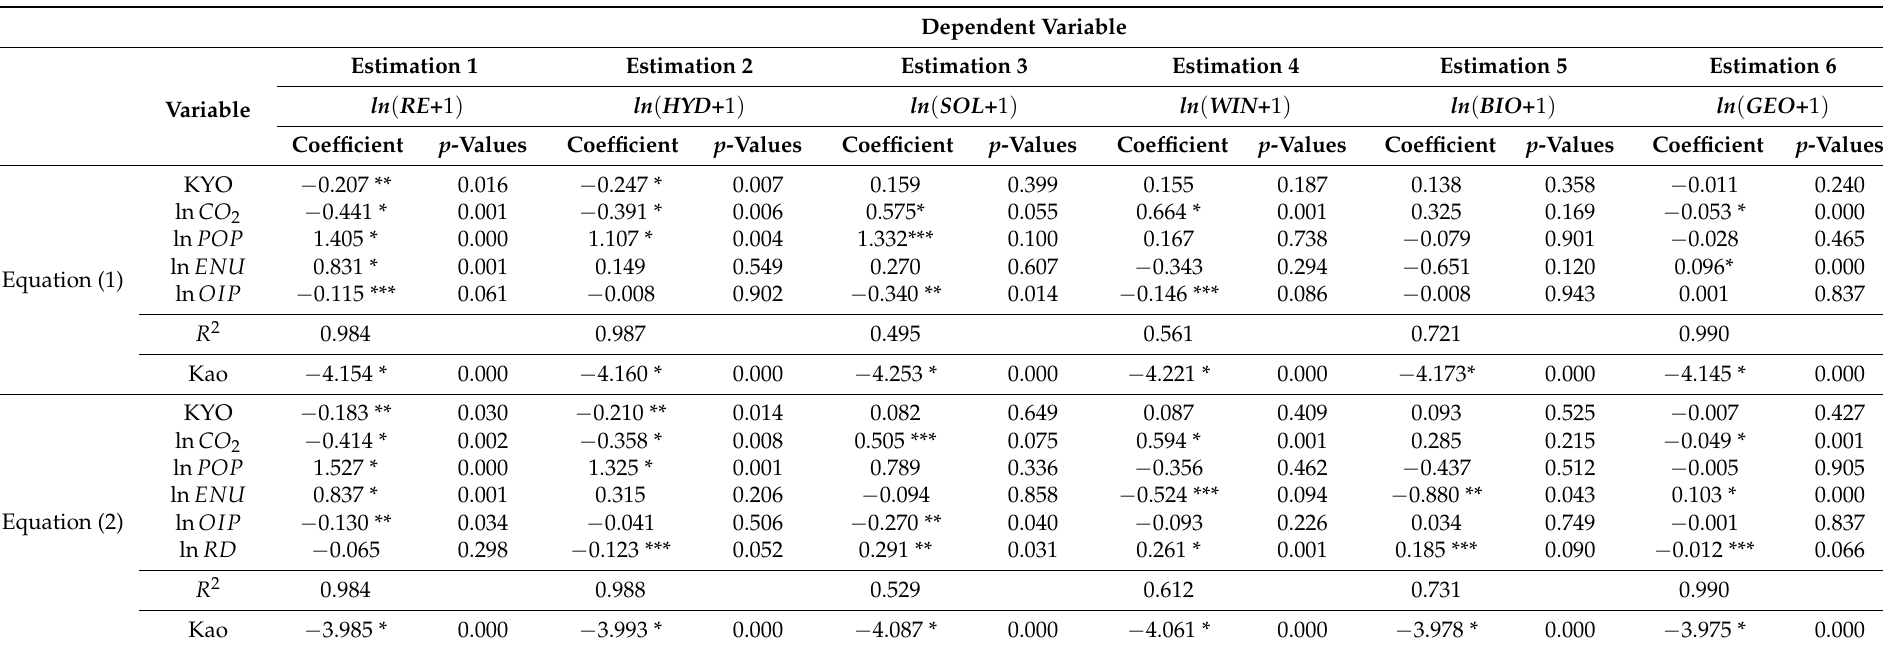
Table 5. Long-run estimation results for equations 1–4 for different RE sources as dependent variables using panel FMOLS model, along with panel cointegrating test results by equation and RE